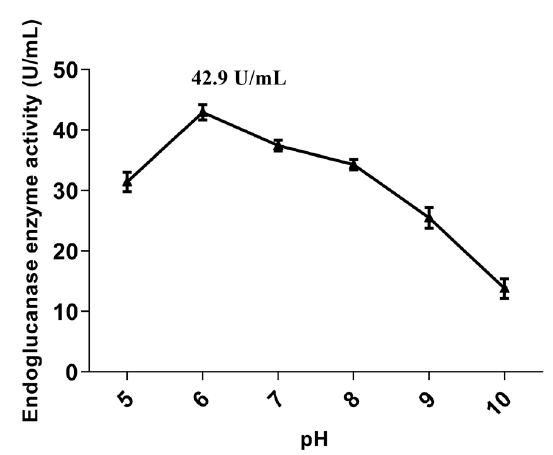
Figure 8. The effect of incubation period on the endoglucanase enzyme activity. Culture condions: MPP concentration 50 g/L, 2 g/L yeast extract, Temperature 40°C, and initial pH 6.0.